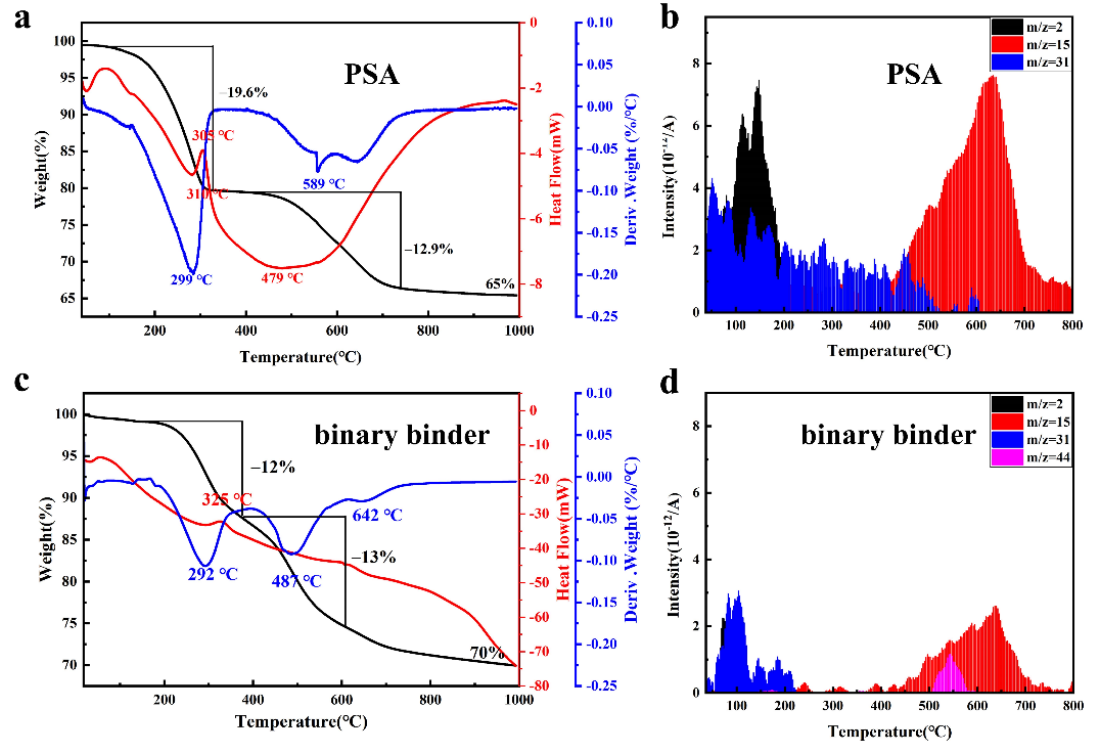
Figure 3. ( a ) TG-DSC-DTG curves of PSA resin; ( b ) MS spectrum of PSA resin; ( c ) TG-DSC-DTG curves of the binary binder; ( d ) MS curves of the binary binder. XRD pattern indicates that the amorphous PSA matrix converted to SiC ceramic at 1400 ◦ C in Figure 4a. The peaks at 26.6 ◦ , 41.5 ◦ , and 43.4 ◦ are attributed to the lattice plane (002), (100), and (101) of SiC (JCPDS card no. 73-1708), respectively. Compared to